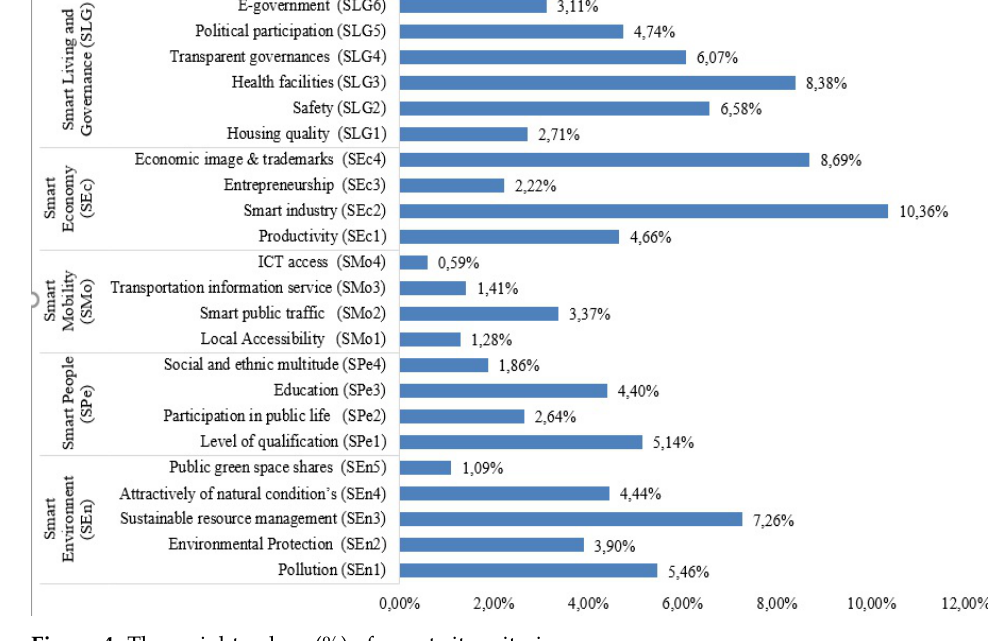
Figure 4. The weight values (%) of smart city criteria.